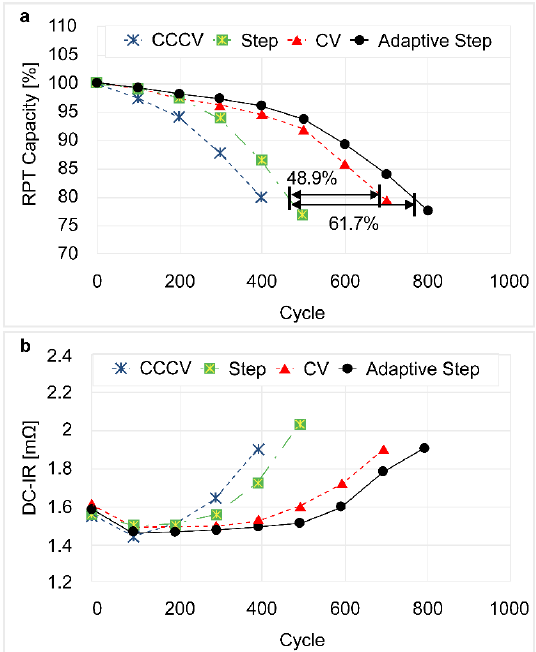
Figure 7. DVA plots of ICR18650-33F showing the variations in cell cycle lives upon the implementation of different charging methods. ( a ) The capacity of the battery; and ( b ) The direct current internal resistance of the